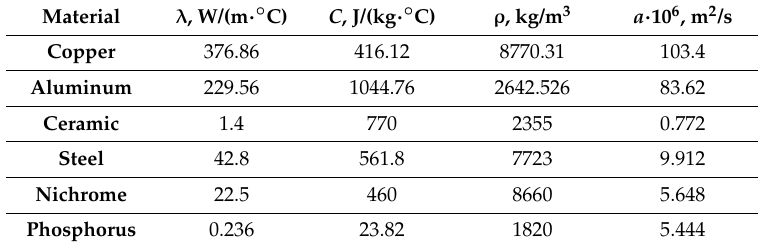
Table 3. Thermal and physical characteristics of holder materials (average values for the temperature range of 200–500 ◦ C in line with the